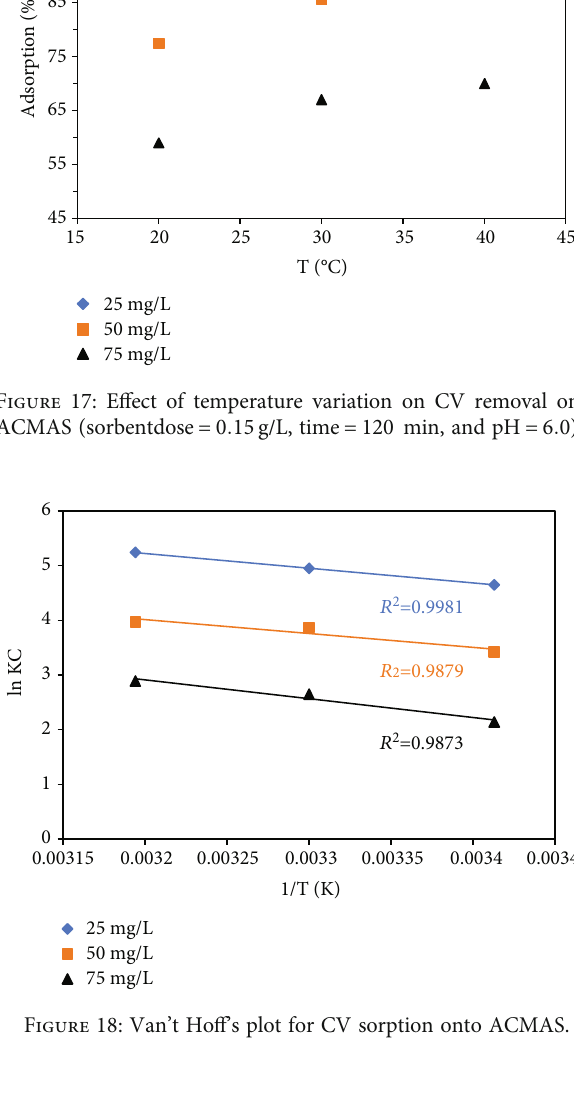
Figure 18: Van ’ t Ho ff ’ s plot for CV sorption onto